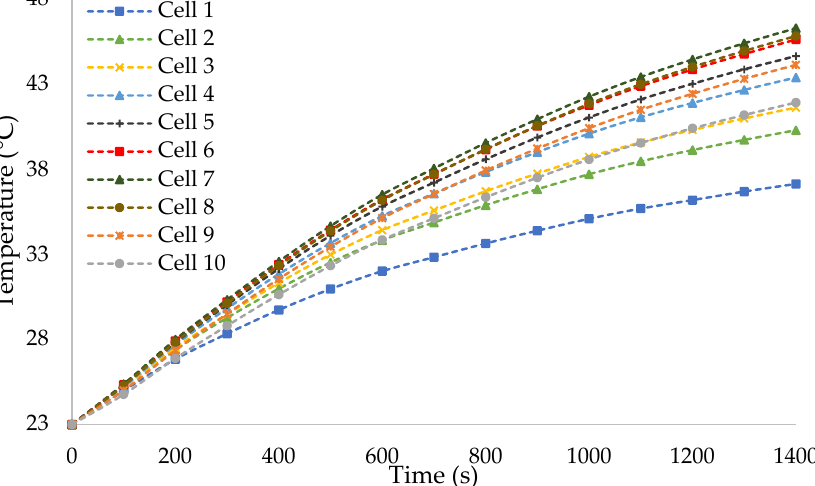
Figure 6. Temperature curves of all the LiCs in the module with inlet air velocity of V = 2 m/s.